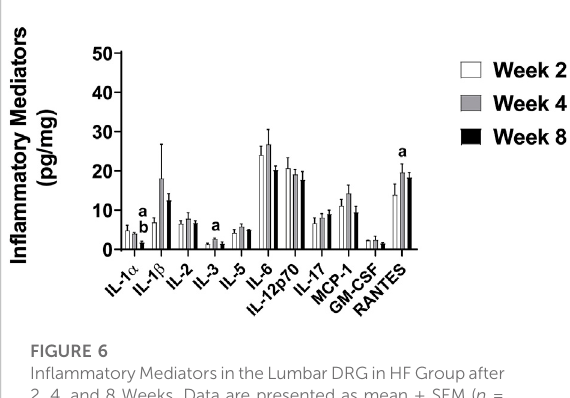
FIGURE 6 In fl ammatoryMediatorsintheLumbarDRGinHFGroupafter 2, 4, and 8 Weeks. Data are presented as mean ± SEM ( n = 3 – 11 mice per group). a p < 0.05 vs wk 2, b p < 0.05 vs wk 4. IL-10, IFN- γ , TNF- α , MIP-1 α were below the limit of detection in the majority of the samples, thus means could not be